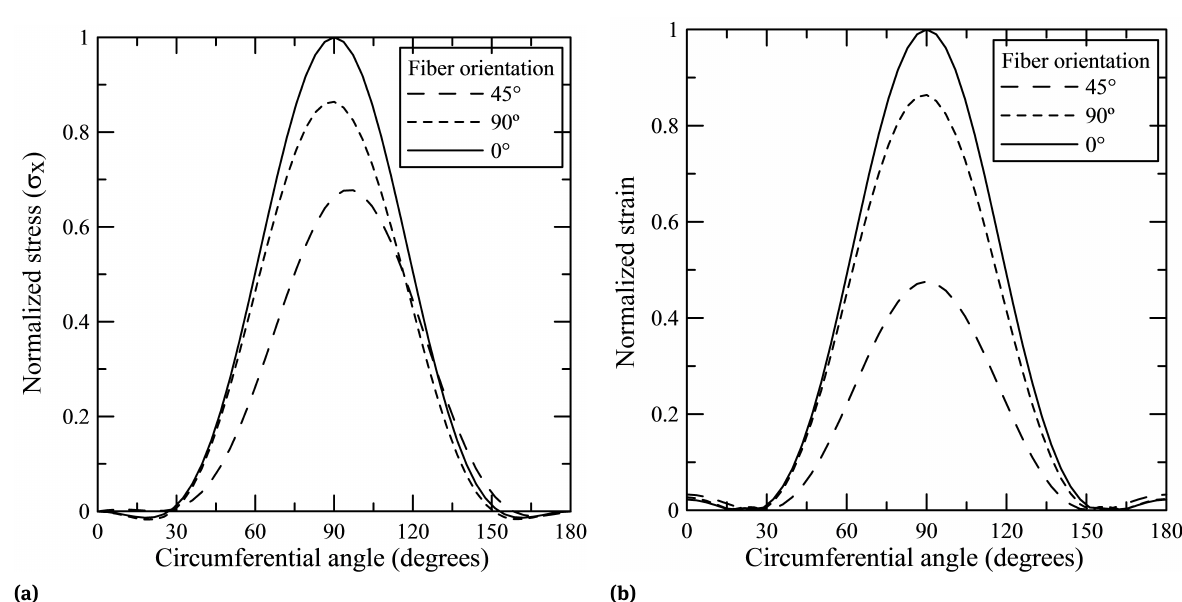
Figure 13: Effect of fiber orientation on normalized: (a) stress ( 𝜎 𝑥 ) and (b) strain around the circumference of hole